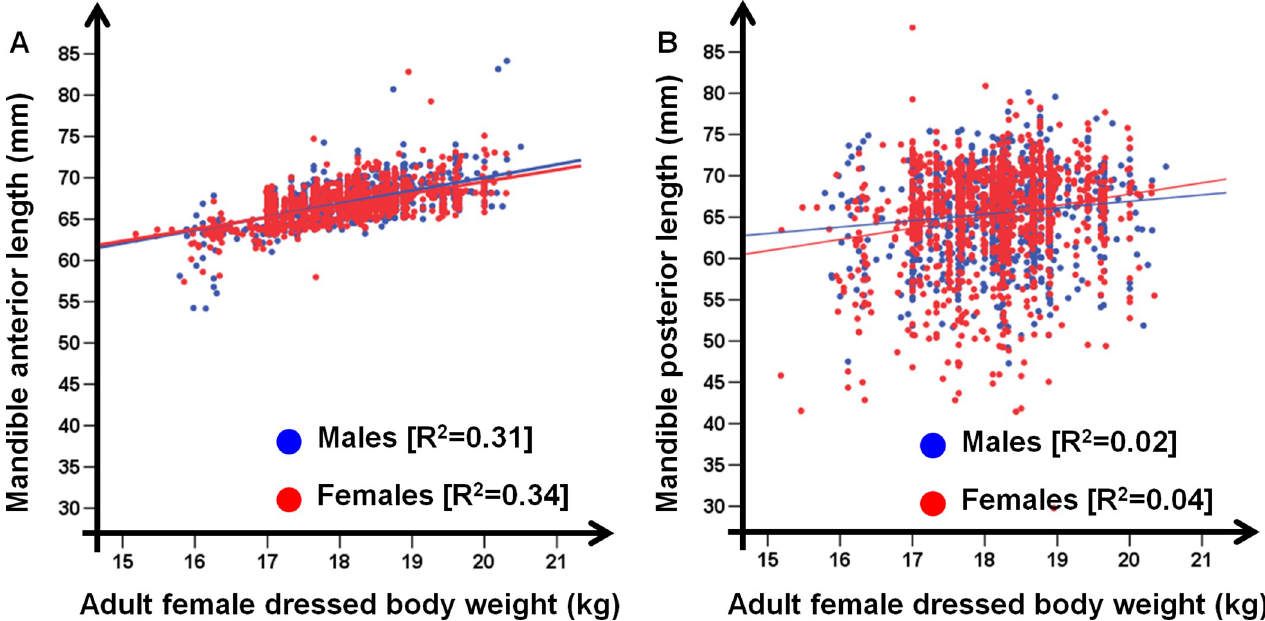
Fig 5. Mandible sections length. Length of the anterior (A) and posterior (B) section of 2,161 mandibles of juveniles (8–10 months; 1,176 females and 985 males), collected during the 2013–2015 hunting seasons (1 st January-15 th March) in the Arezzo province (Tuscany, Central Italy), in relation to the dressed body weight of adult females ( � 2 years). R 2 is reported for each regression